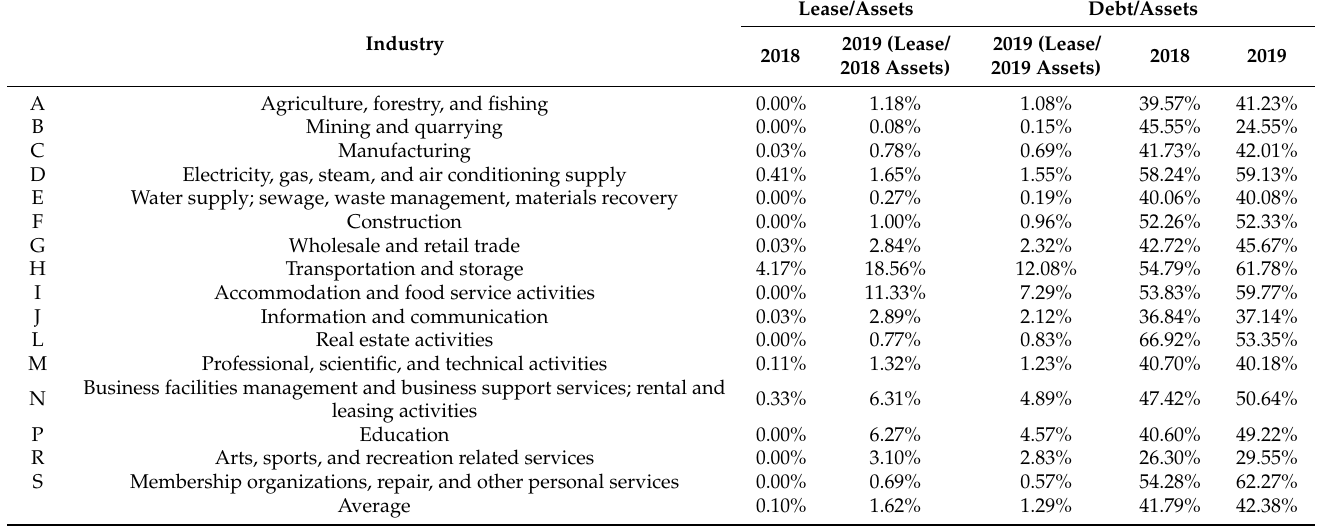
Table 2. Changes in the average lease liabilities-to-assets ratios (Lease/Assets) and total liabilities-to- assets ratios (Debt/Assets) by industry before and after K-1116